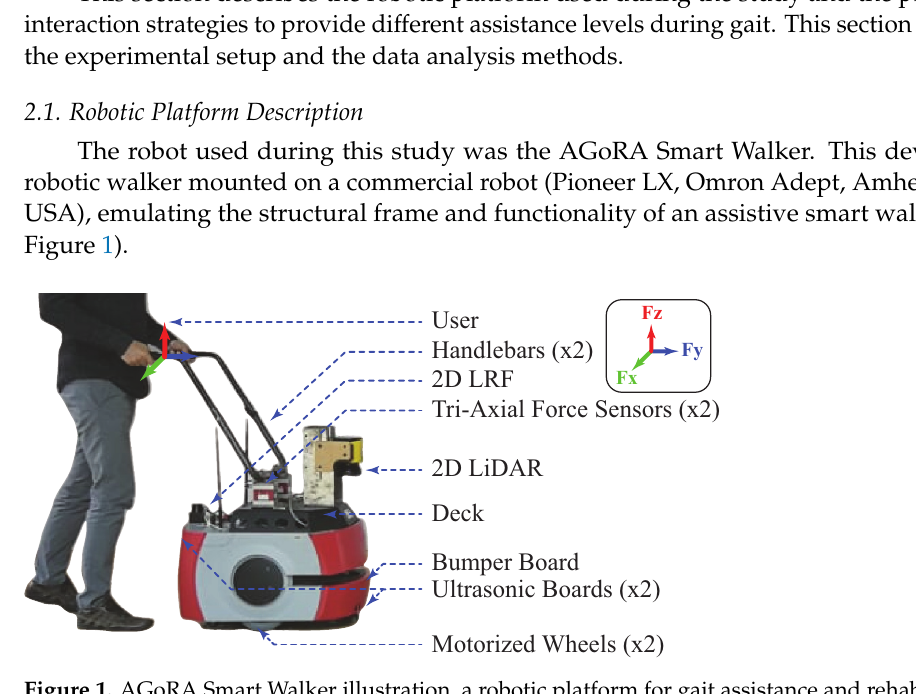
Figure 1. AGoRA Smart Walker illustration, a robotic platform for gait assistance and rehabilitation. This platform uses several sensors, actuators, and processing units: (1) Two motorized wheels and two caster wheels for propulsion and stability; (2) two encoders and one Inertial Measurement Unit (IMU) to measure position, orientation, and speed; (3) a 2D Light Detection and Ranging Sensor (LiDAR) (S300 Expert, SICK, Waldkirch, Germany) for environment sensing; (4) two ultrasonic boards for user detection and low-rise obstacles detection; (5) two tri-axial force sensors (MTA400, FUTEK, Irvine, CA, USA) to estimate the user’s navigation commands; and (6) a 2D Laser Range-Finder (LRF) (Hokuyo URG- 04LX-UG01, Osaka, Japan) for the user’s gait estimation [19]. The device’s onboard